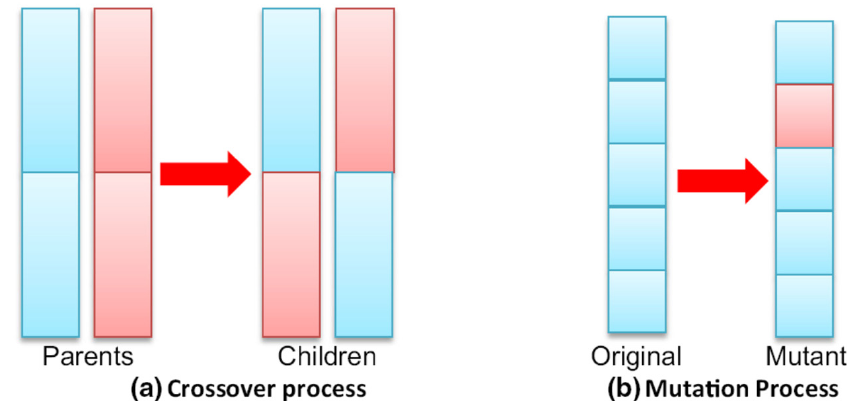
Figure 7. Genetic algorithm operators.